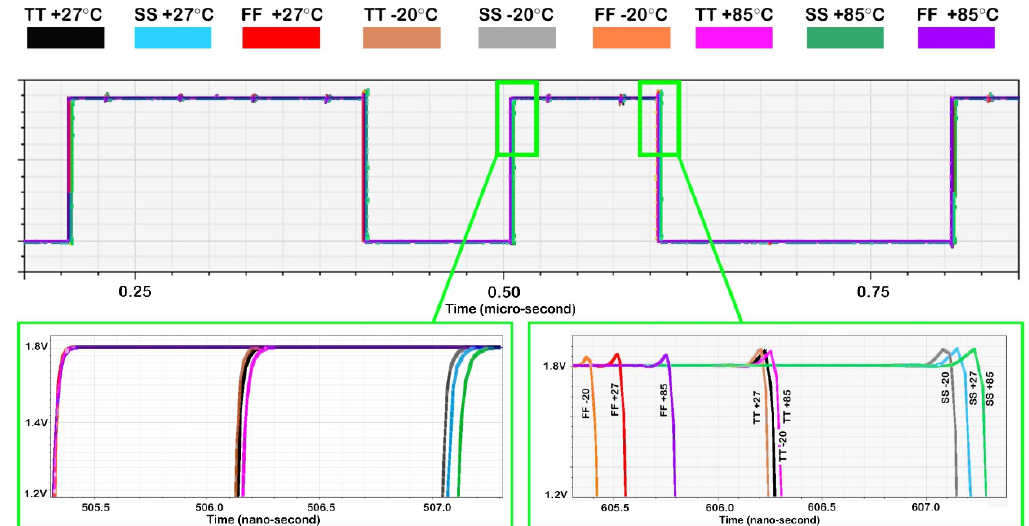
Figure 8. Process corners / temperatures simulation for demodulated data.